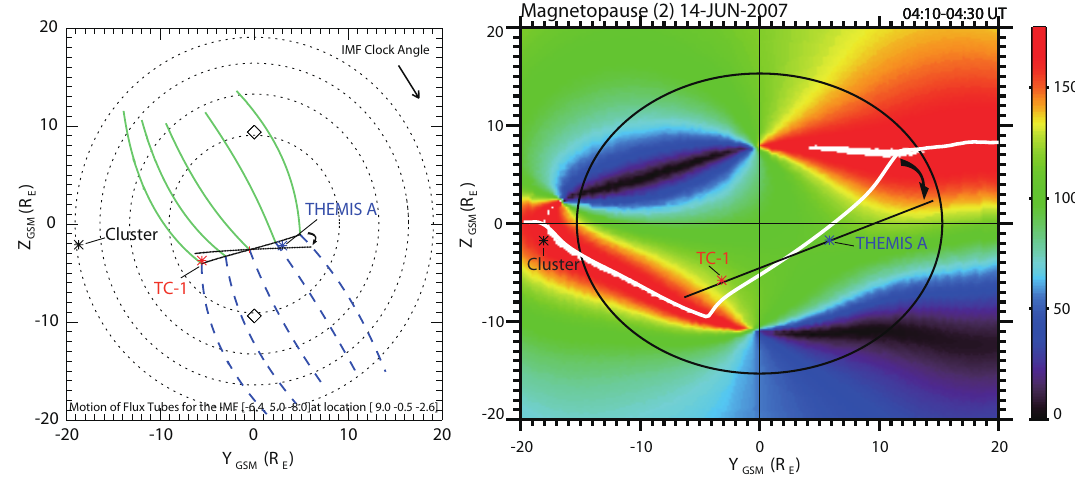
Fig. 3. The left panel shows the Cooling analysis of FTE motions from a predicted sub-solar X-line (taken as the position of maximum merging current at the MP), as seen from the Sun. The right panel shows the modelled, shear angles between the draped magnetosheath field and T96 Tsygenenko model. The white regions on the flanks are where the shear angle is close to anti-parallel and show possible reconnection locations extended into the flanks. The white line crossing the magnetopause is the most likely location of the reconnection line, as predicted by the Maximum Magnetic Shear Model (Trattner et al., 2007). Nearby spacecraft locations are shown as black crosses, and the black line is the final orientation of the fitted (Cooling) merging current